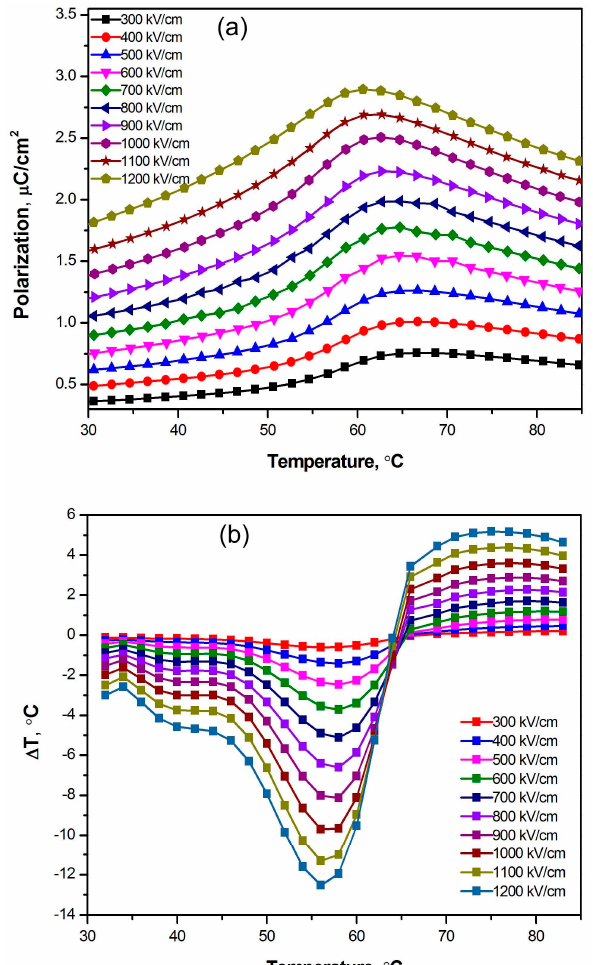
Figure 3. Temperature-dependent polarizations ( a ) and negative ECE temperature changes Δ T ( b ) in